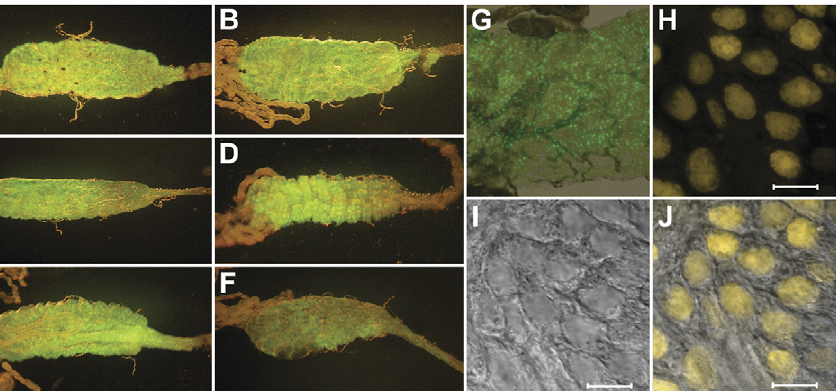
Figure 2. Expression of fluorescent protein in the midgut. Images A to F show a representative image of eYFP expression in the female midgut of driver lines Cln, Drt, Dgl, F, G and Ivr respectively crossed with the responder line Mbl, photographed through a GFP-B filter. (G) Midgut eYFP expression at 100 6 magnification photographed through a fluorescein filter. Images H to J are confocal microscope images taken with YFP filtering (H), transmitted light (I), and merged (I) demonstrating localization to midgut nuclei. All guts are from sugarfed mosquitoes Scale bar is